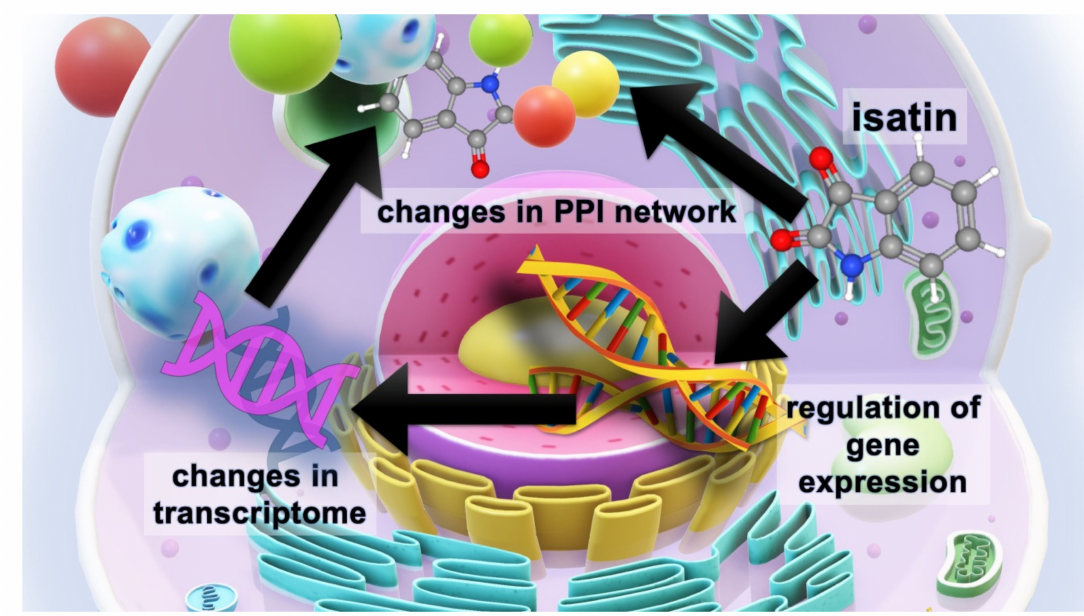
Figure 5. The scheme illustrating the multilevel e ff ects of the neuroprotective dose of isatin (100 mg / kg, 24 h). Isatin has a significant impact on the expression of responsive genes and thus influences the cell transcriptome. Acting on isatin-binding proteins, isatin changes protein–protein interactions (PPI), which are also influenced by the altered proteome, thus causing global changes in the PPI